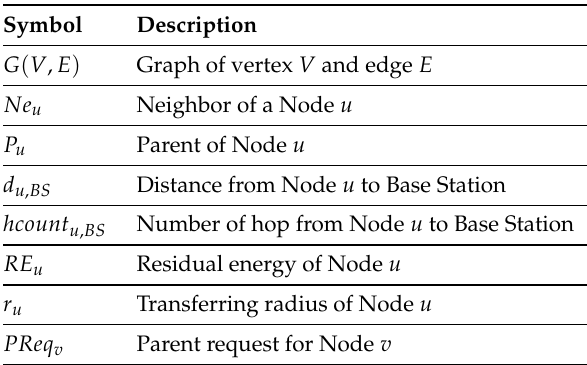
Table 3. Summary of the used